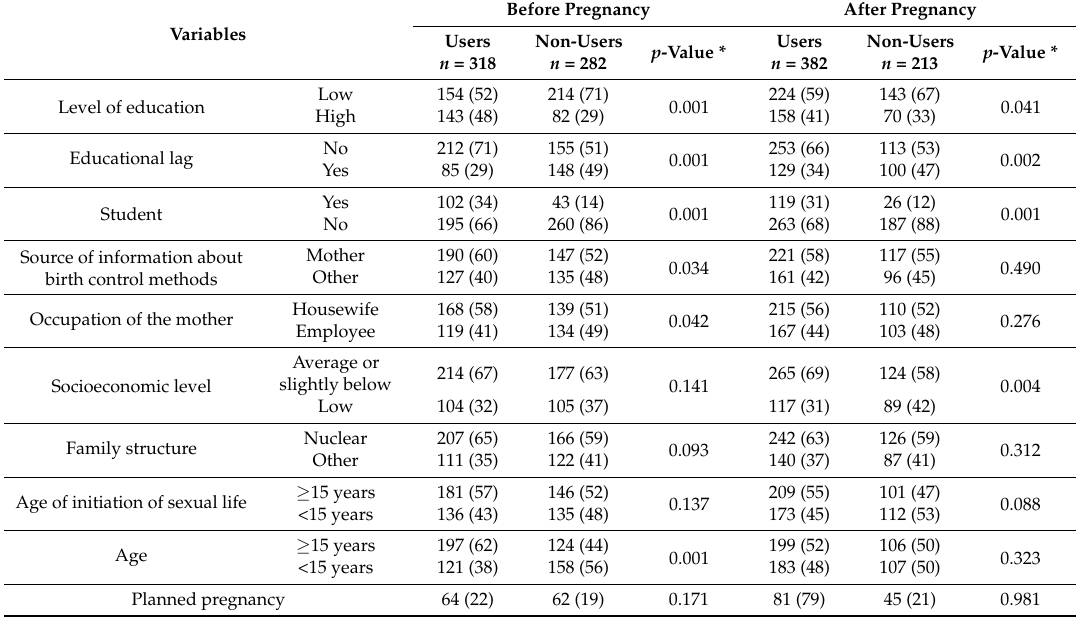
Table 3. Percentage distribution of characteristics for adolescents who did and did not use birth control methods before and after